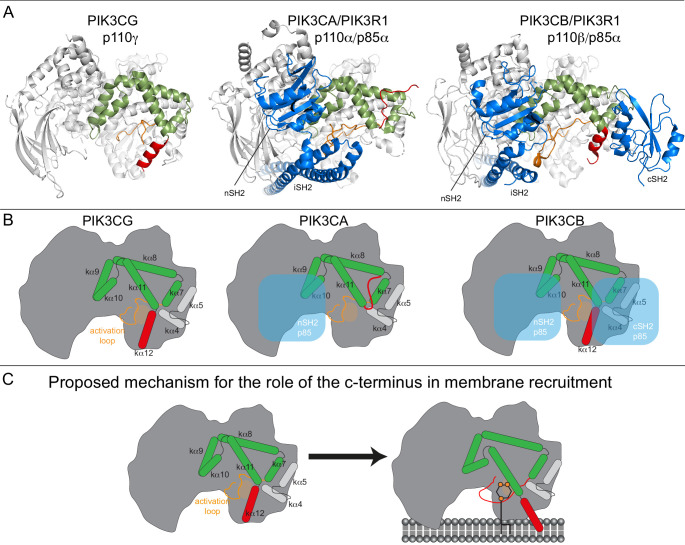
Comparing the different regulatory mechanisms that maintain the C-terminal regulatory motif in a inhibited state in the class I PI3Ks.(A) A structural model comparing the architecture of the C-terminal regulatory motif in PIK3CG (PI3Kγ, PDB: 6AUD [Safina et al., 2017]). PIK3CA (PI3Kα, PDB: 4JPS [Furet et al., 2013]), PIK3CB (PI3Kβ, PDB: 2Y3A [Zhang et al., 2011]). The activation loop is shown in orange, with the kα12 helix shown in red (not a helix in PI3Kα). The p85 regulatory subunits interacting with the motif in PI3Kα and PI3Kβ are shown in blue, with the domains of the nSH2, iSH2, and cSH2 annotated on the structure. (B) Cartoon model shown in the same format as in Figure 1, highlighting the regulatory motif and its interaction with regulatory subunits. (C) Cartoon model highlighting putative conformational changes in the regulatory motif required for membrane binding.